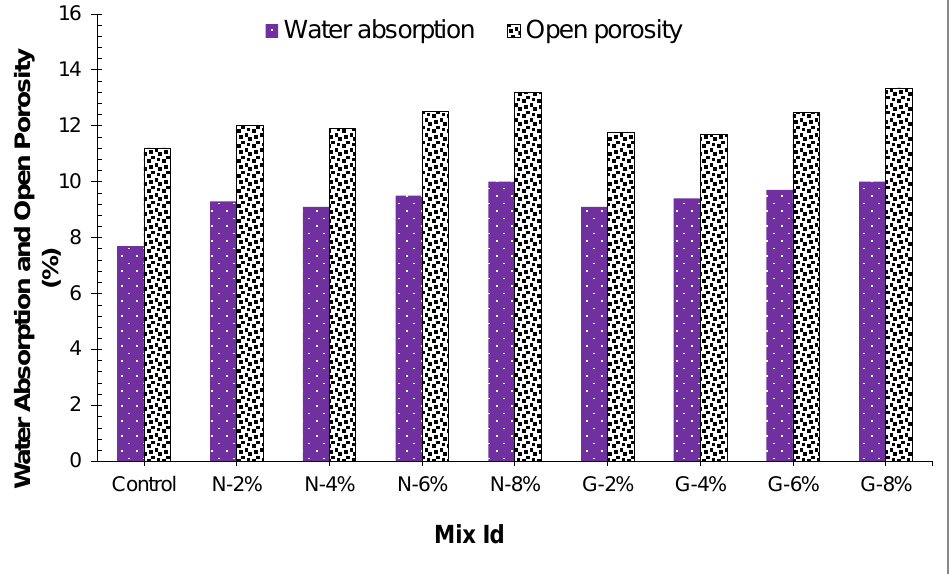
Figure 16. Water absorption and open porosity of concrete samples.